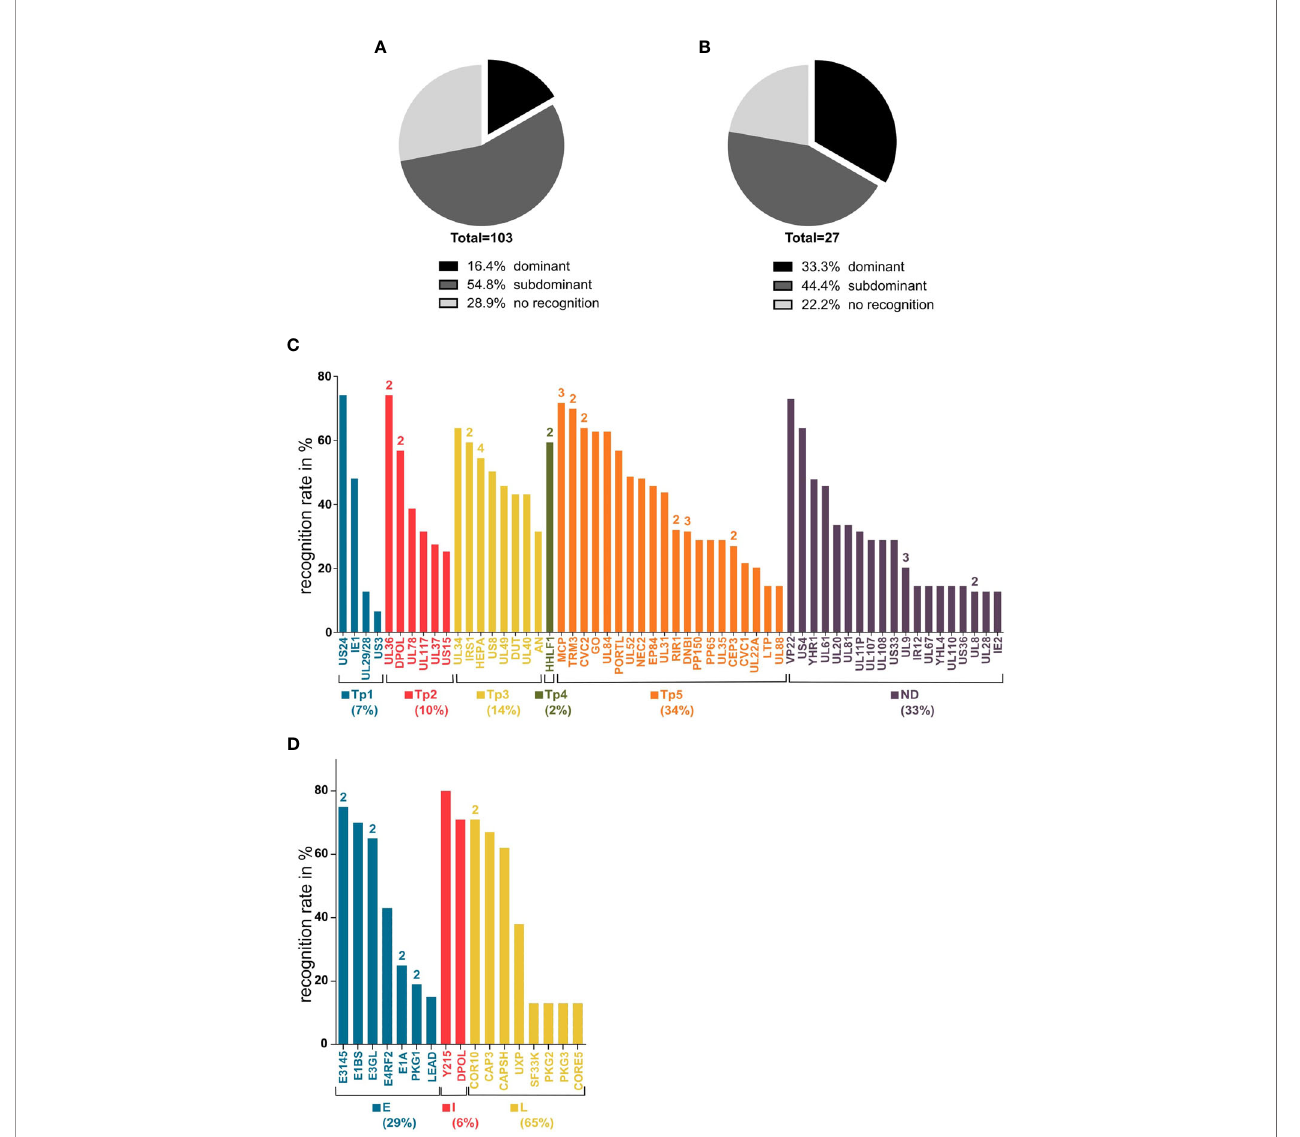
FIGURE 4 | Recognition rates in ELISpot and source antigen spectrum. Panels (A, B) show the recognition rates (rr) of epitope candidates determined in ELISpot assays after a 12-day stimulation with peptides and IL-2. (A) all tested HCMV peptides, (B) all tested HAdV peptides. Dominant = rr ≥ 50%; subdominant = rr < 50%; no recognition = no T-cell response detected. Graphs (C, D) show the source antigen spectrum of dominant and subdominant epitopes. For each source protein, the epitope with the highest recognition rate is shown (ELISpot recognition rate in percent). The numbers above the bars indicate the number of epitopes from the respective antigen. (C) Tp1-5, temporal classes of protein expression as de fi ned by Weekes et al. (34); ND, temporal class not determined. (D) . E, early; I, intermediate; L, late (29, 35 –